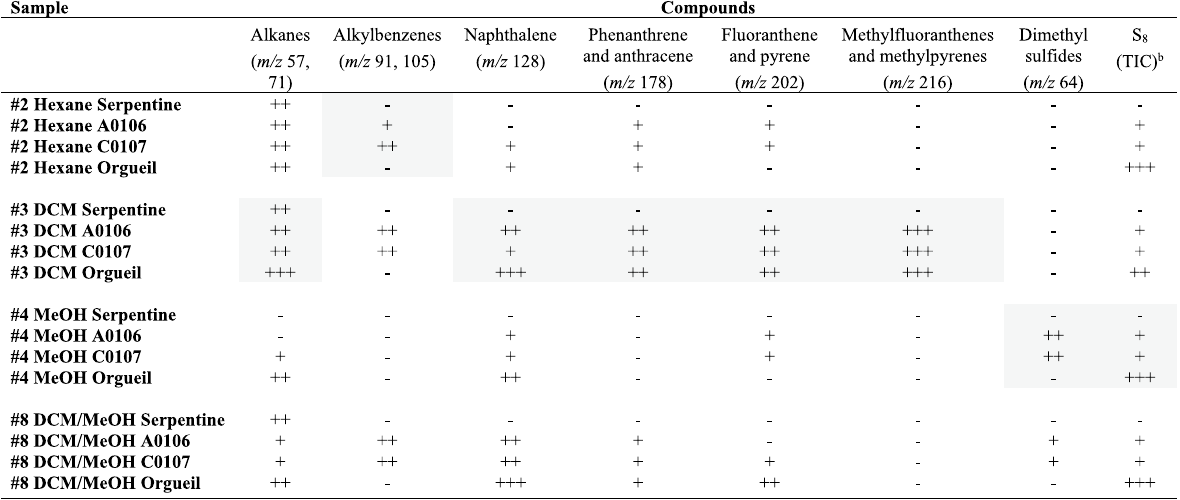
Table 1 Identification of organic compounds and molecular sulfur in the hexane, DCM, methanol, and DCM/methanol extracts of serpentine blanks, Ryugu samples A0106, C0107, and the Orgueil (CI1) meteorite used for comparison